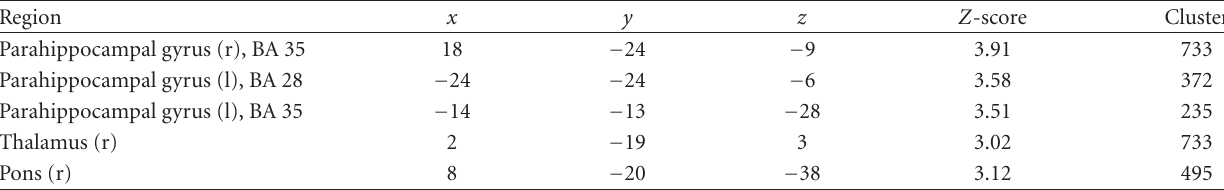
Table 2: Peak correlations between [ 11 C]PIB tracer uptake and CSF BACE1 activity.